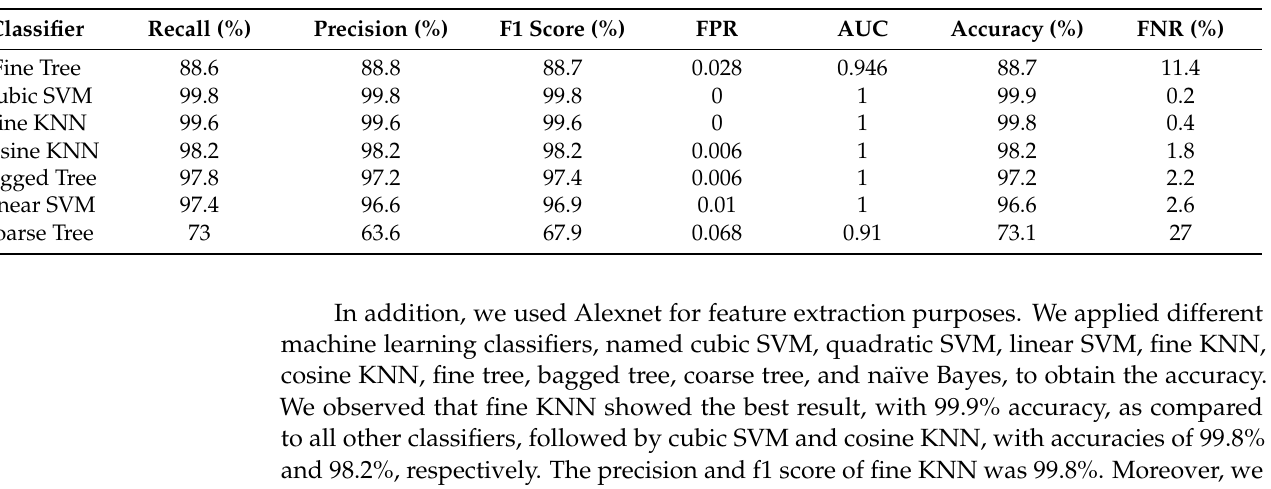
Table 3. Classification results using VGG19 model features.